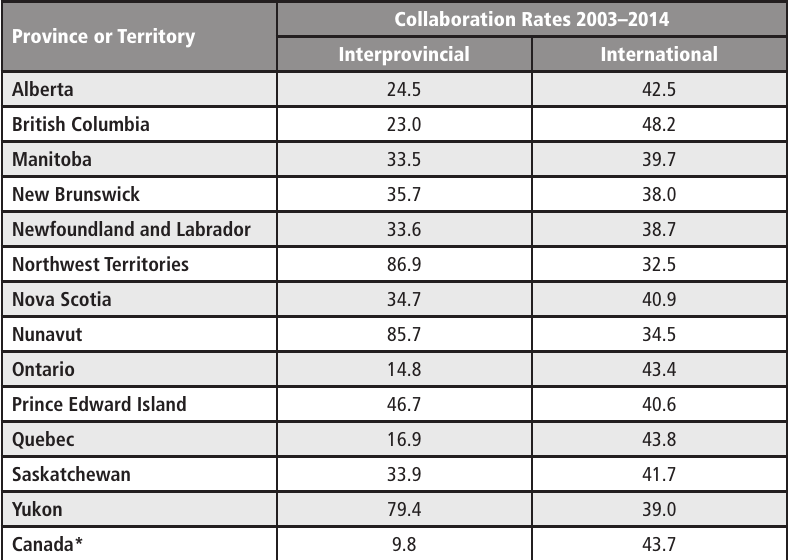
Proportion of Interprovincial and International Collaboration Rates by Canadian Province and Territory, 2003–2014 Province or